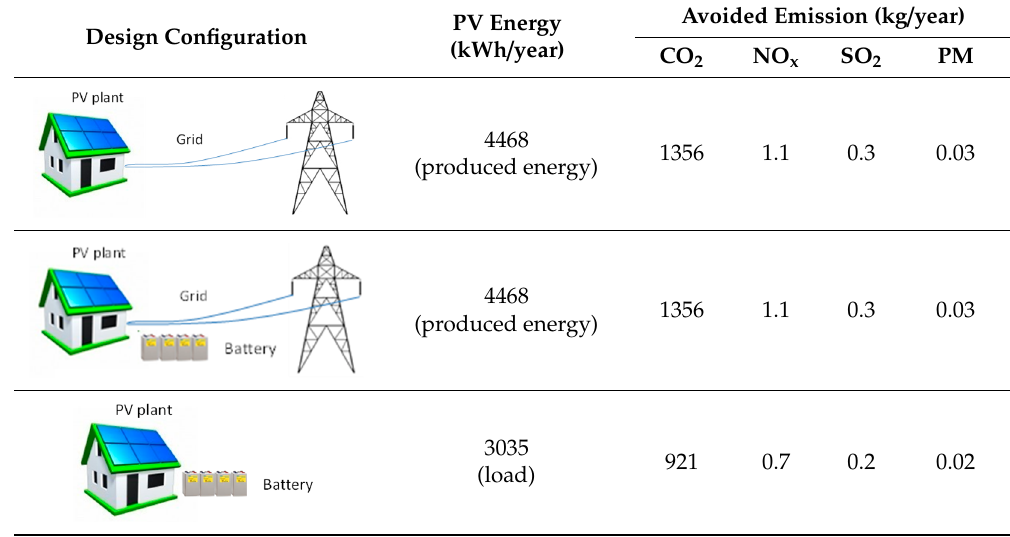
Table 7. Avoided emissions.